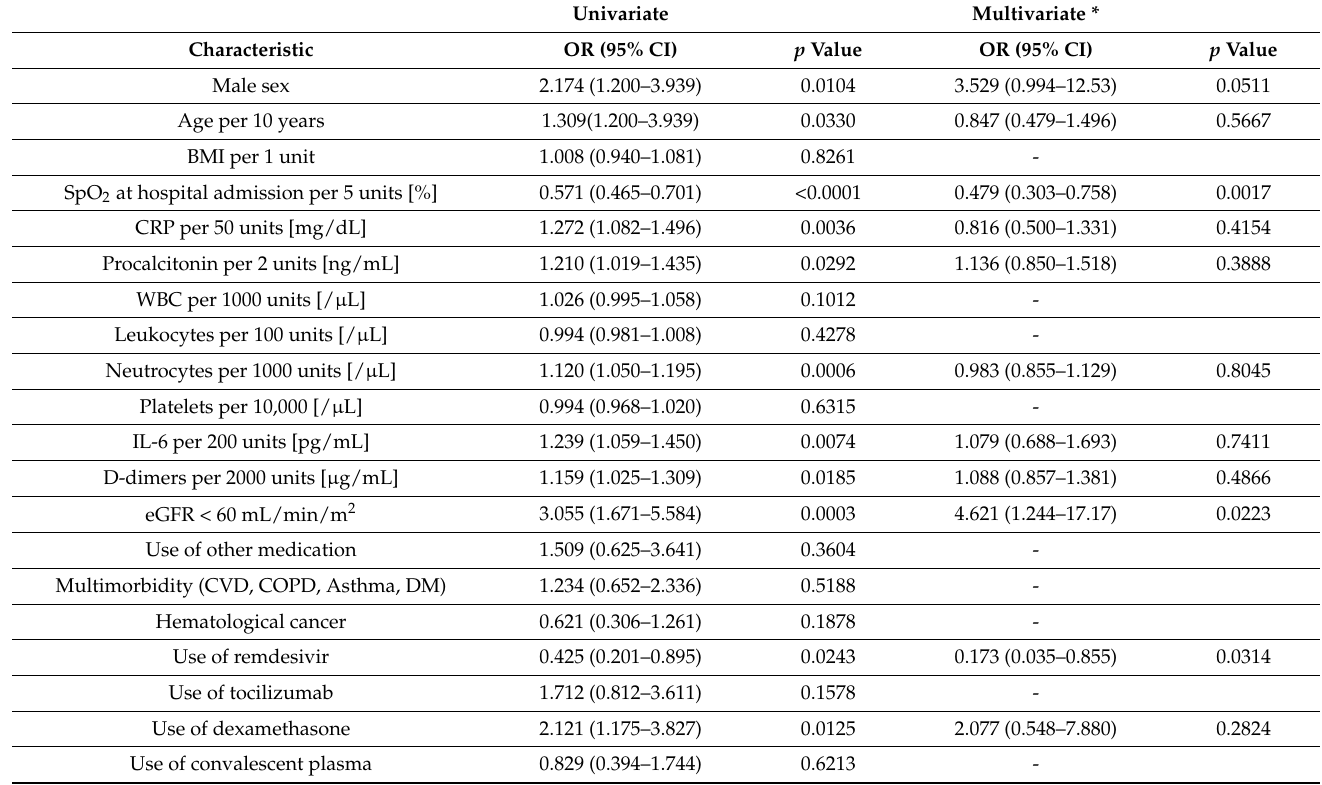
Table 3. Univariate and multivariate logistic regression models for the odds of death. Univariate Multivariate